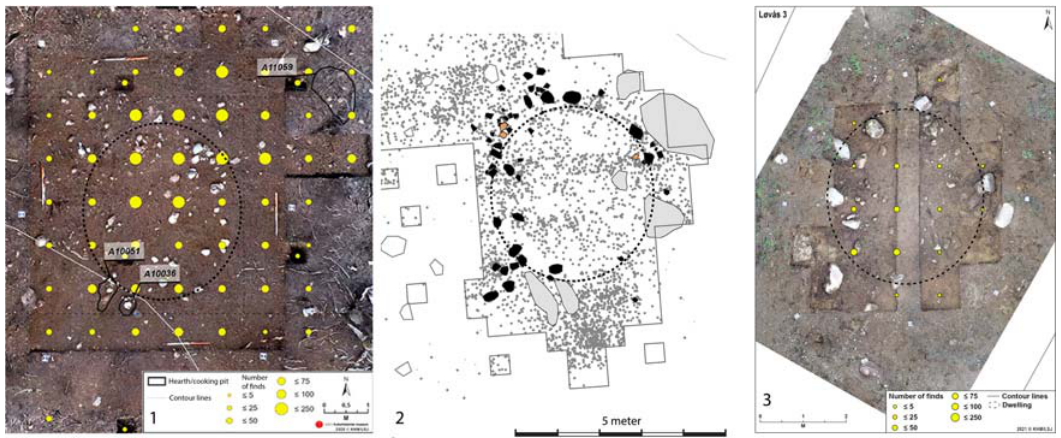
Figure 6: Dwelling structures: Tent fl oors at Adal ( no. 1 ) and Pjonkerød A ( no. 2 ) , and one of the hut fl oors at Løvås ( no. 3 ) . The artefact distribution within the structures is indicated by yellow dots for no. 1 and 3, an by grey dots for no. 2. A dashed circle suggests the extent of the fl oor of each structure, showing the similarity in size. Maps: Tina Granados, Axel Mjærum and